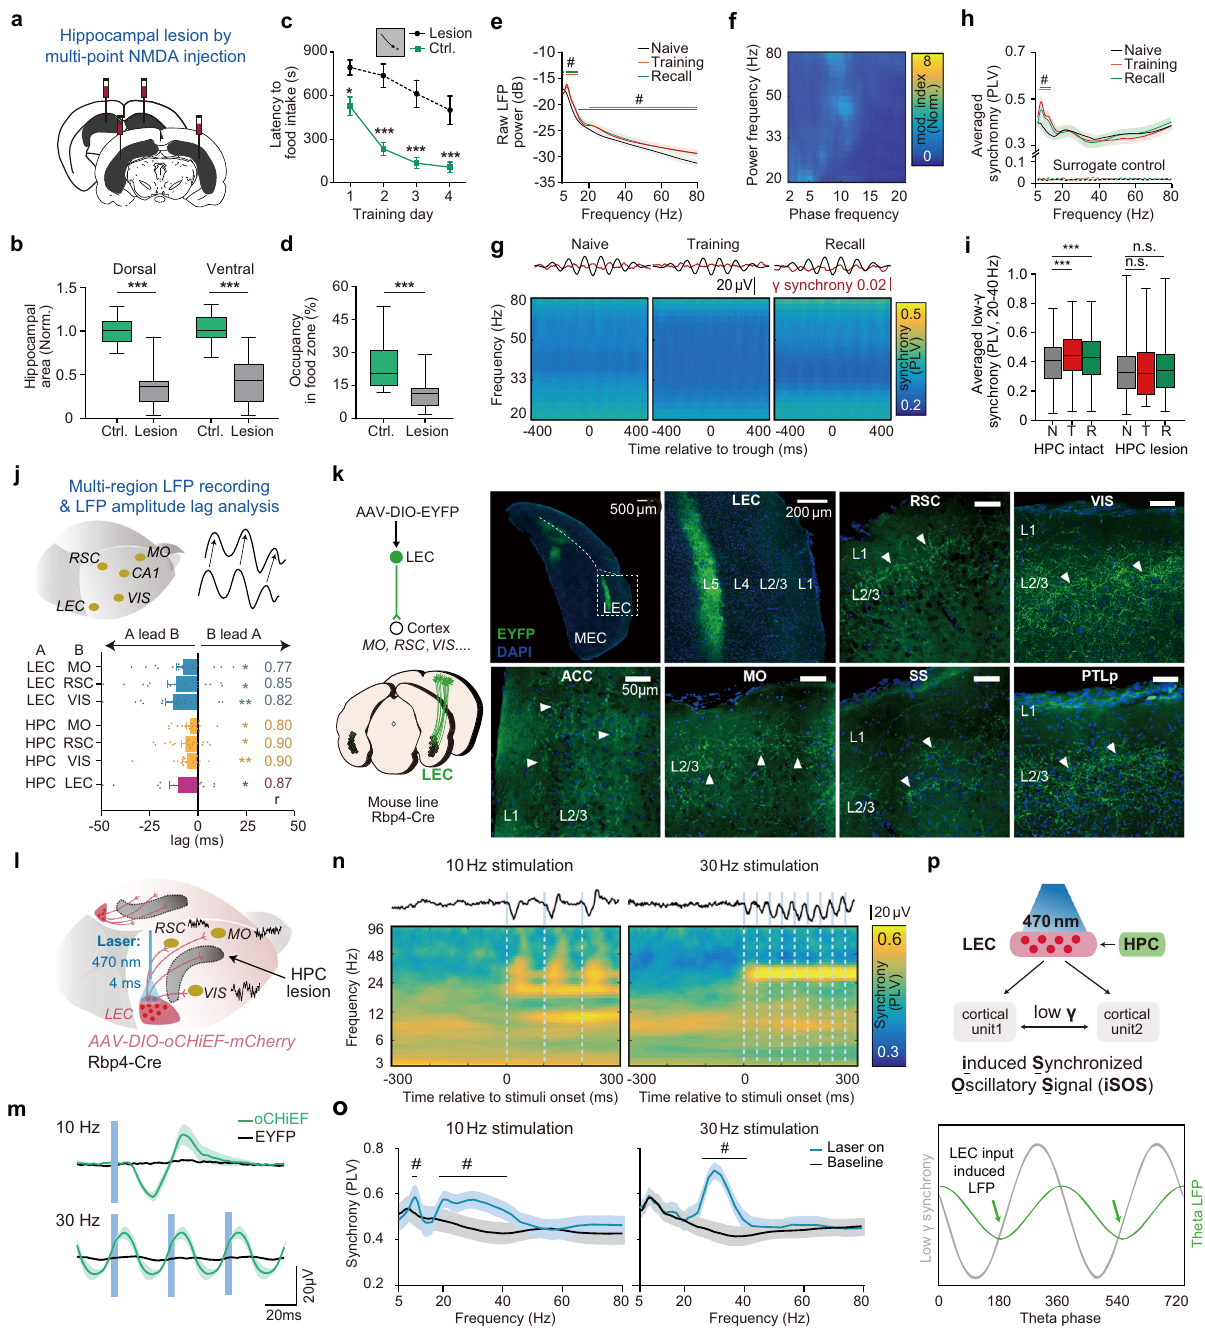
MO, VIS, and RSC. Activating the cell bodies of L5 LEC neurons or their efferent fi bers induced reliable cortical LFP signals in recorded cortices (Fig. 2m, Supplementary Fig. 9b). Upon optogenetic activation in LEC (470 nm, 4 ms), LFP response latencies were similar across cortical regions (MO: 25.50 ± 1.87 ms, RSC: 25.25 ± 1.46 ms, VIS: 25.40 ± 2.11 ms, Supplementary Fig. 9d, e). The engaged actives showed signi fi cant bursts on low gamma band, no matter the frequency of the optic stimuli (Fig. 2n). Such LEC-mediated cortical oscillation in the low gamma band is an intrinsic property of each cortical unit, as each activation-induced LFP response lasted for ~36 ms